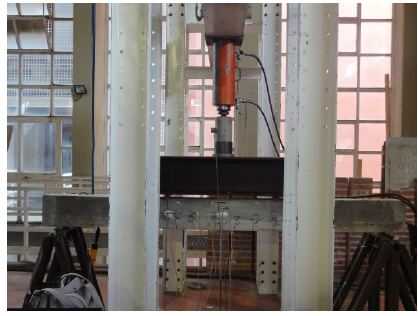
Figure 3. Experimental test setup.